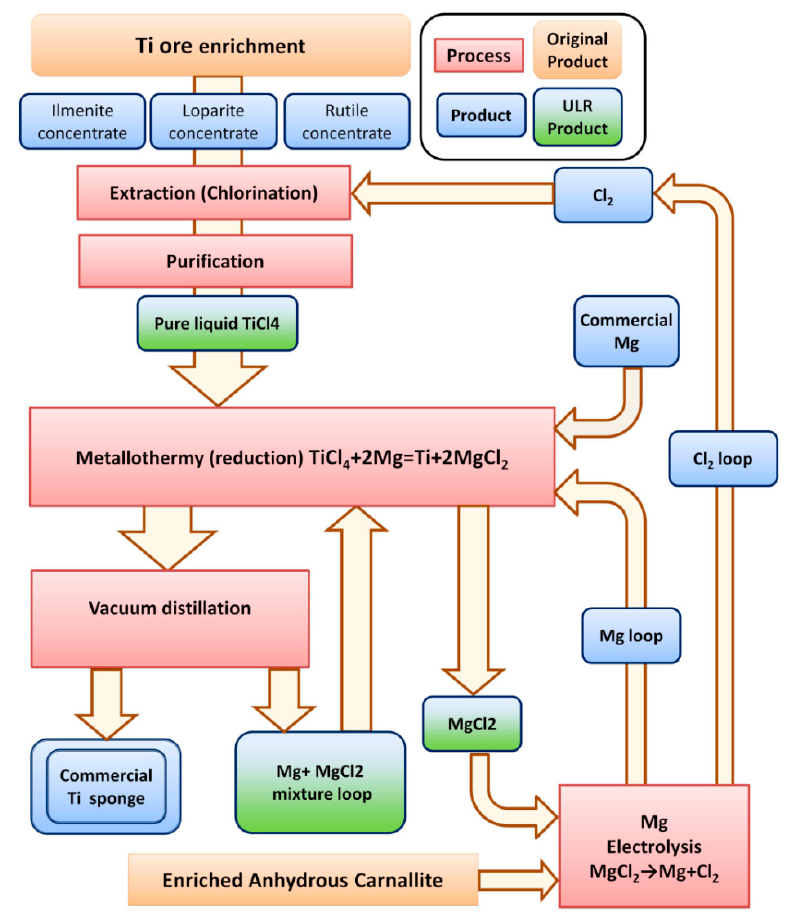
Figure 1. Simplified scheme of the industrial titanium sponge production process [8,10]. Ultra-low- radioactive (ULR) products discovered within the ULR titanium R&D are marked in green.